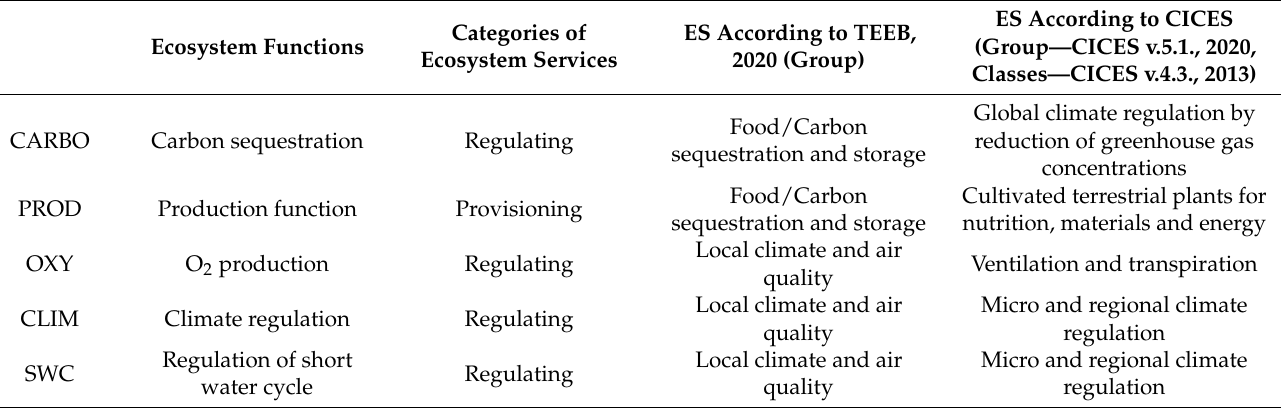
Table 1. Classification of evaluated ecosystem functions and